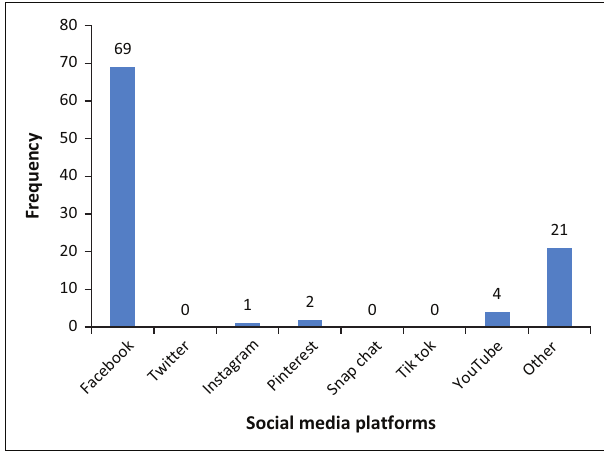
FIGURE 1: Social media platform(s) used by librarians for public library services ( N =